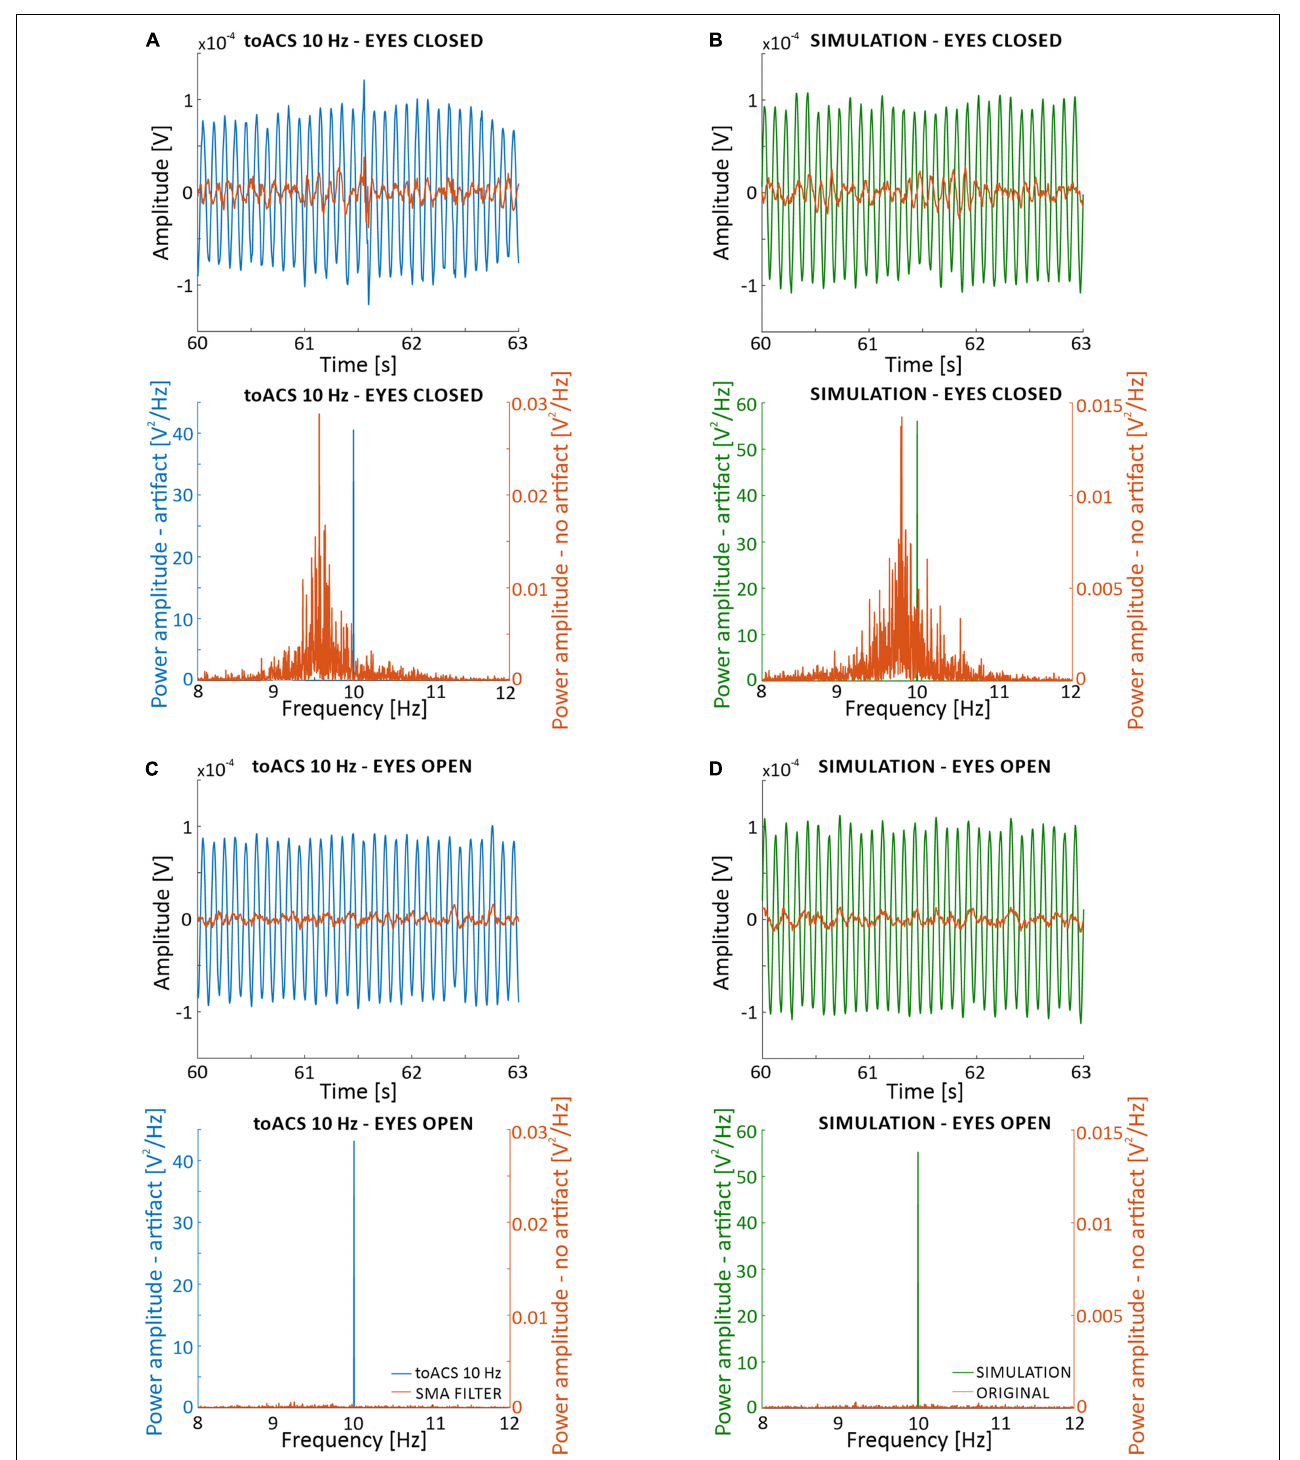
FIGURE 6 | Effects of simple moving average (SMA) filtration on 5-min of EEG signal recorded from the O2 electrode from the first participant with real stimulation artifact (i.e., blocks st2 and st5 ) (A,C) , and with a superimposed artificial sinusoidal function (i.e., blocks sh2 and sh5 ) (B,D) . Parameters of the filtration are: 1-period segments and 900-segment artifact templates. (A) Time and frequency analysis for the eyes closed condition with real stimulation artifact. (B) Time and frequency analysis for the eyes closed condition with superimposed artificial sinusoid. (C) Time and frequency analysis for the eyes open condition with real stimulation artifact. (D) Time and frequency analysis for the eyes open condition with superimposed artificial sinusoid. The superimposed artificial sinusoid used in (B,D) was of 10 Hz frequency and 0.0002 V amplitude.